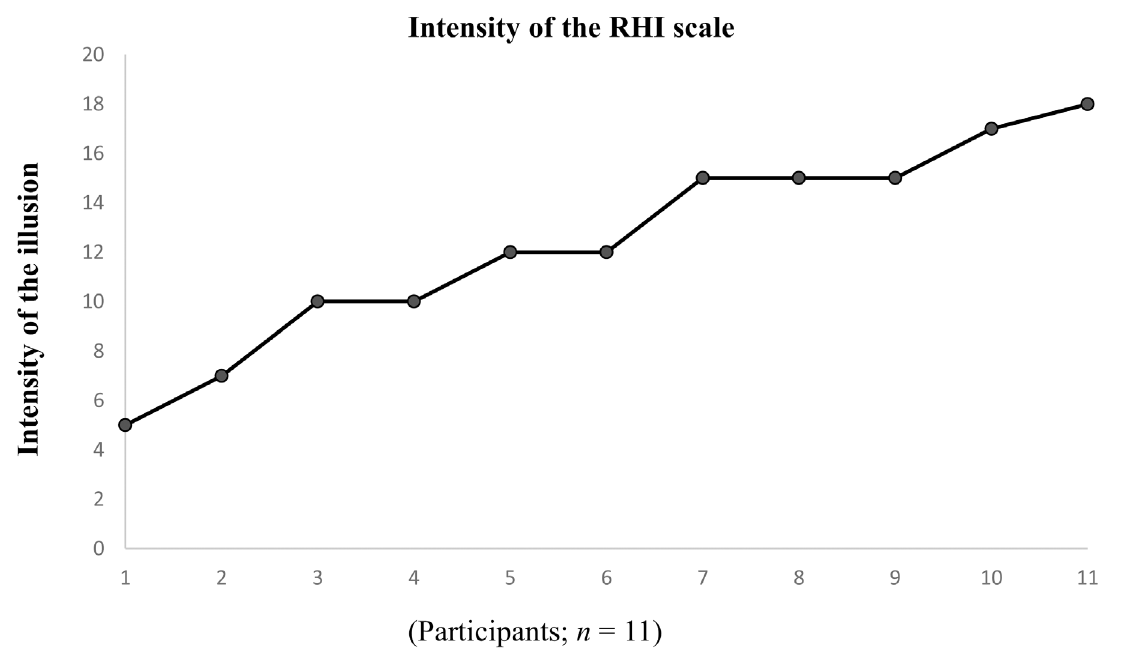
Fig 2. Participants ’ ratings on the intensity of the RHI scale for the main